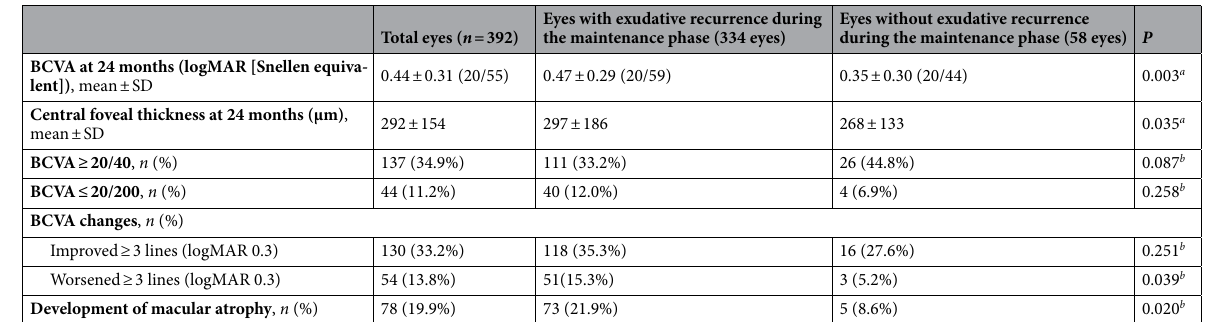
Table 2. Treatment outcomes after the 2-year anti-VEGF treatment. BCVA best-corrected visual acuity, logMAR logarithm of the minimum angle of resolution, SD standard deviation, VEGF vascular endothelial growth factor. a Student’s t-test. b Chi-square test.